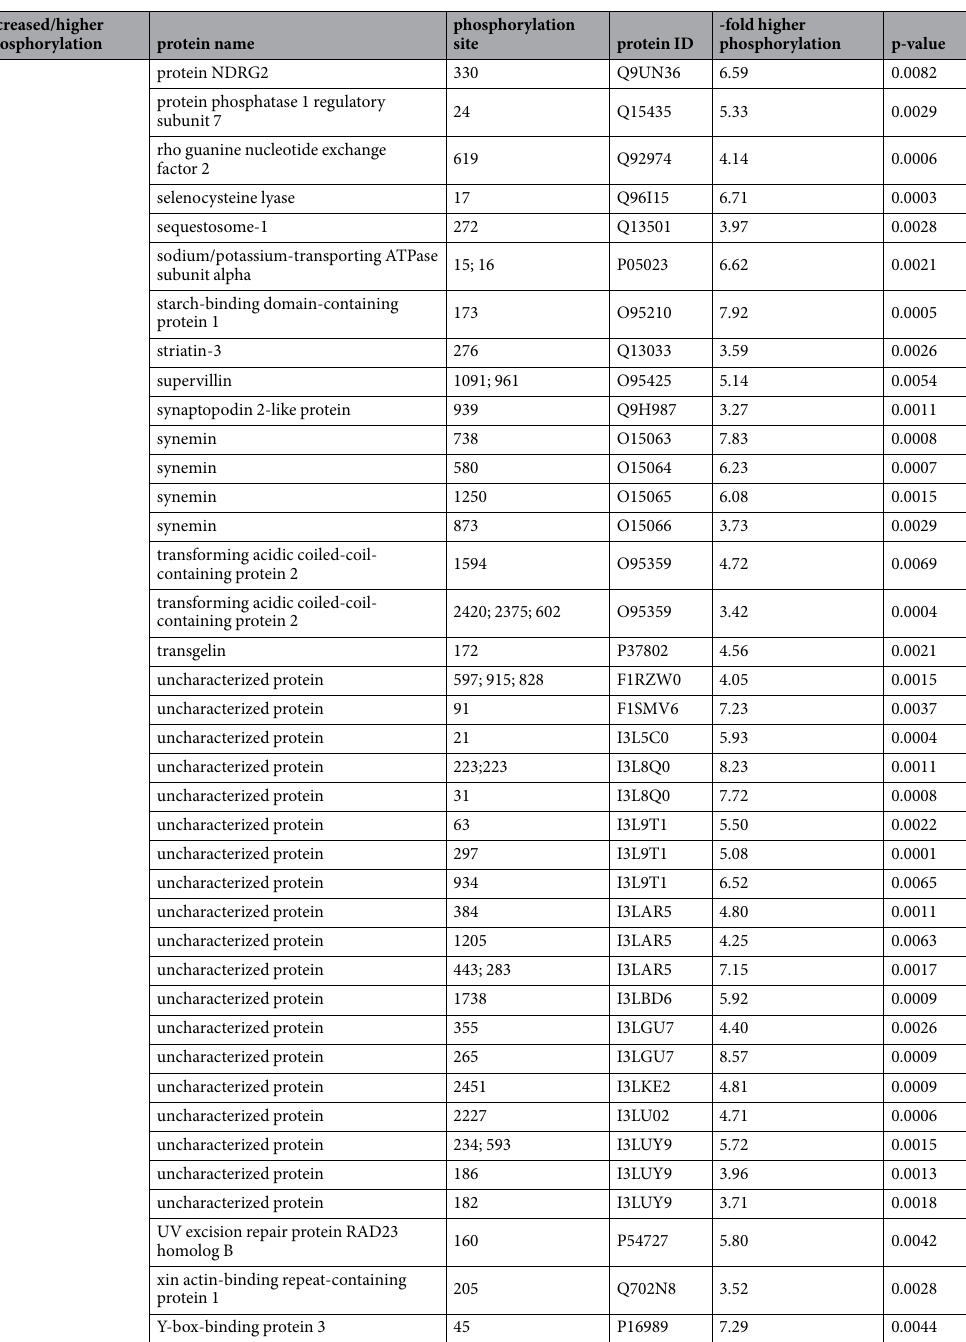
Table 2. Phosphoproteins in porcine LV biopsies identified with a difference in FDR-based statistical analysis. All phosphoproteins with a false discovery rate (FDR)-based statistical difference between remote ischemic preconditioning (RIPC) and sham at baseline or at early reperfusion, respectively, or difference between baseline and early reperfusion with RIPC or with sham after phosphopeptide enrichment of porcine left ventricular biopsies. All proteins were compared by unpaired (between RIPC and sham) Student’s